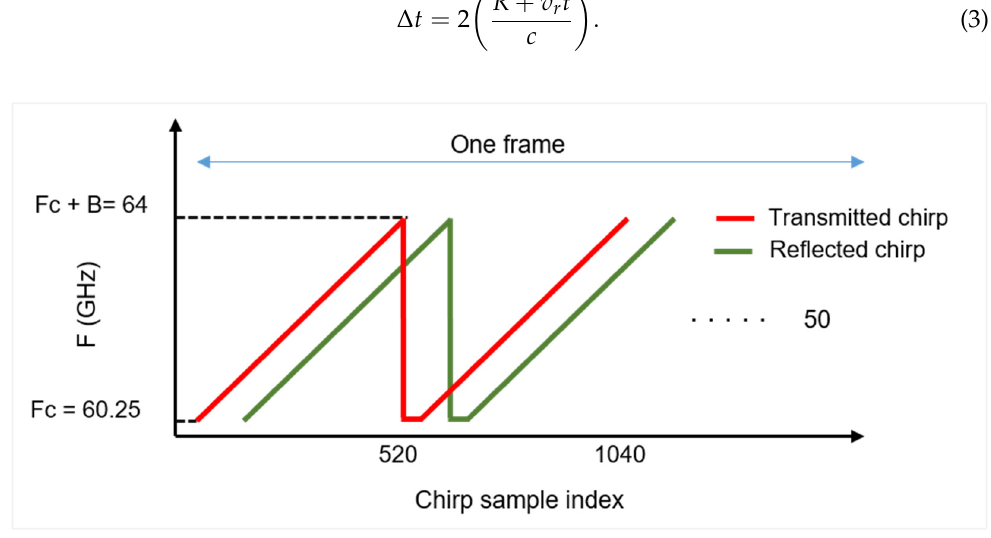
Figure 2. Chirp of FMCW radar spanning a bandwidth of B Hz.